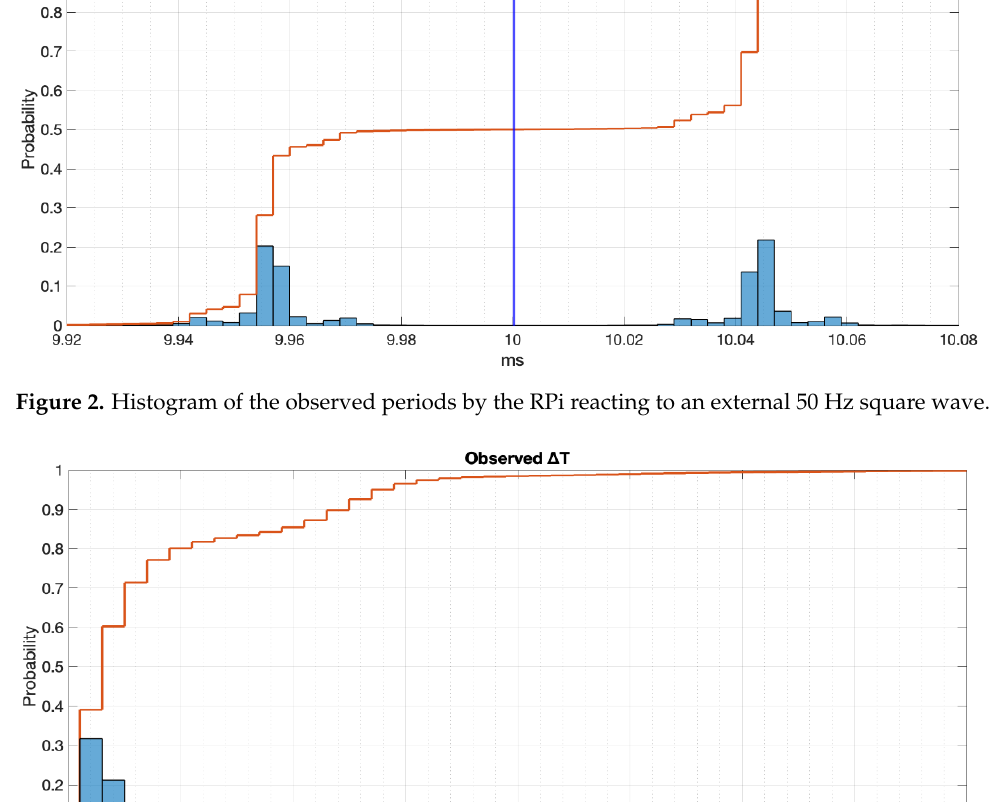
Table 2. Observed periods to external interrupts: important values. Figure 3. Histogram of the time drifting for both sides of the square wave.